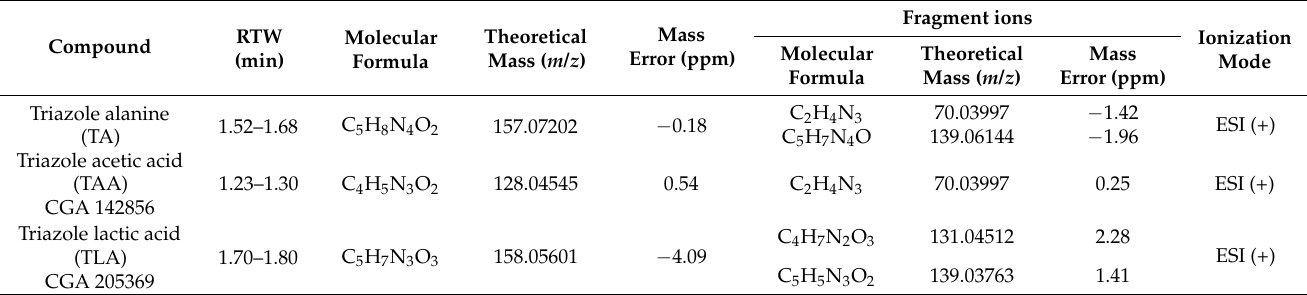
Table 2. Characteristic parameters for tentatively identified metabolites of flutriafol by suspected analysis 1